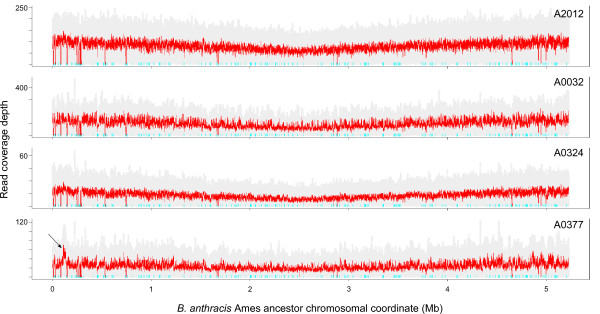
Unique coverage plots of B. anthracis genomes. Reads were mapped to the B. anthracis Ames ancestor chromosome using mapreads. Each row represents a B. anthracis chromosome (strain indicated at the upper right of each plot). Grey dots indicate coverage values at each position and red lines indicate the running mean with a window size of 1,000. Cyan tick marks near the × axis indicate the location of non-unique 35-mers in the chromosome: no reads can map uniquely to these sequences. The arrow in the A0377 plot indicates the amplified genomic region depicted in detail in Figure 4. The V-shaped profile of the coverage plot is due to the fact that replicating bacteria initiate a second round of chromosomal replication before the completion of the ongoing round, resulting in higher copy number at the origin of replication (at the ends of the plot) and lower copy number at the terminus (center of the plot).